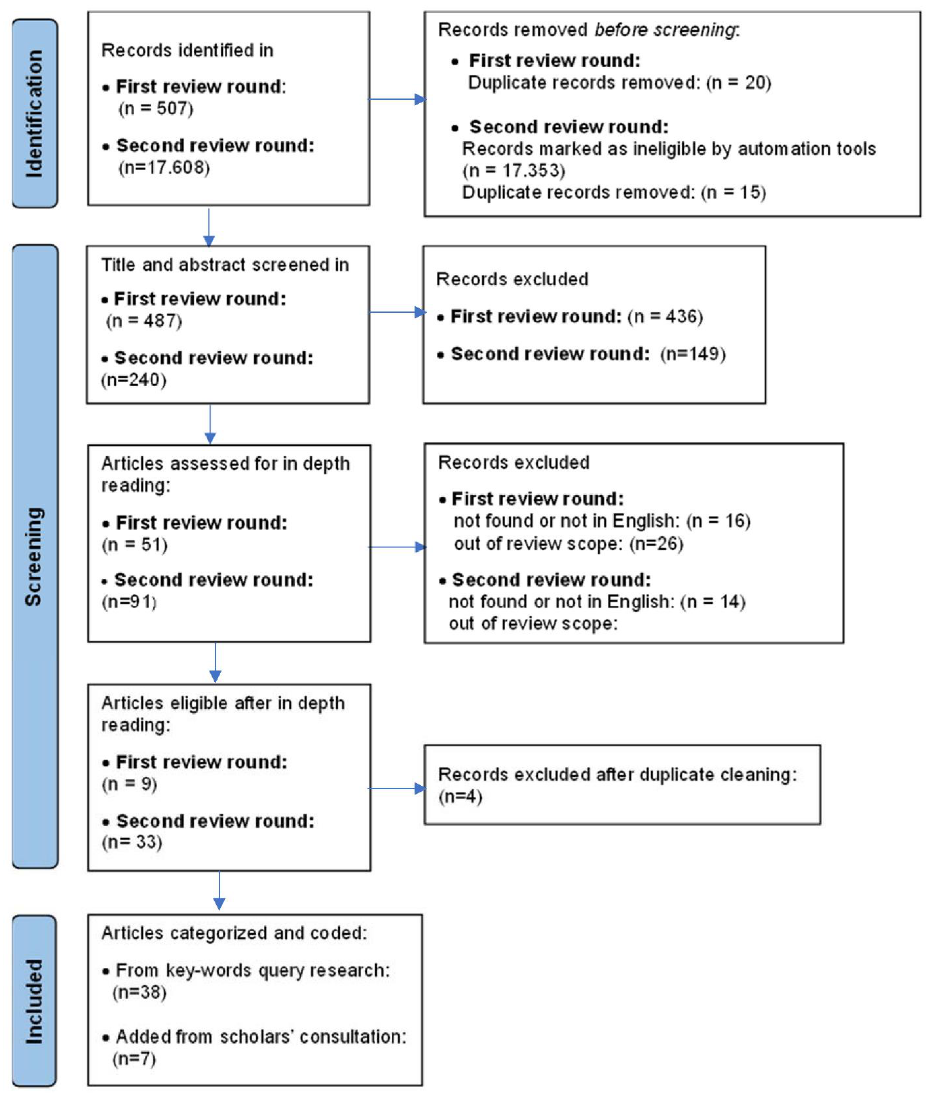
Figure 2. Flow diagram of skimming papers procedure based on PRISMA procedure. Diagram adapted from Page, 2021(source: own elaboration).